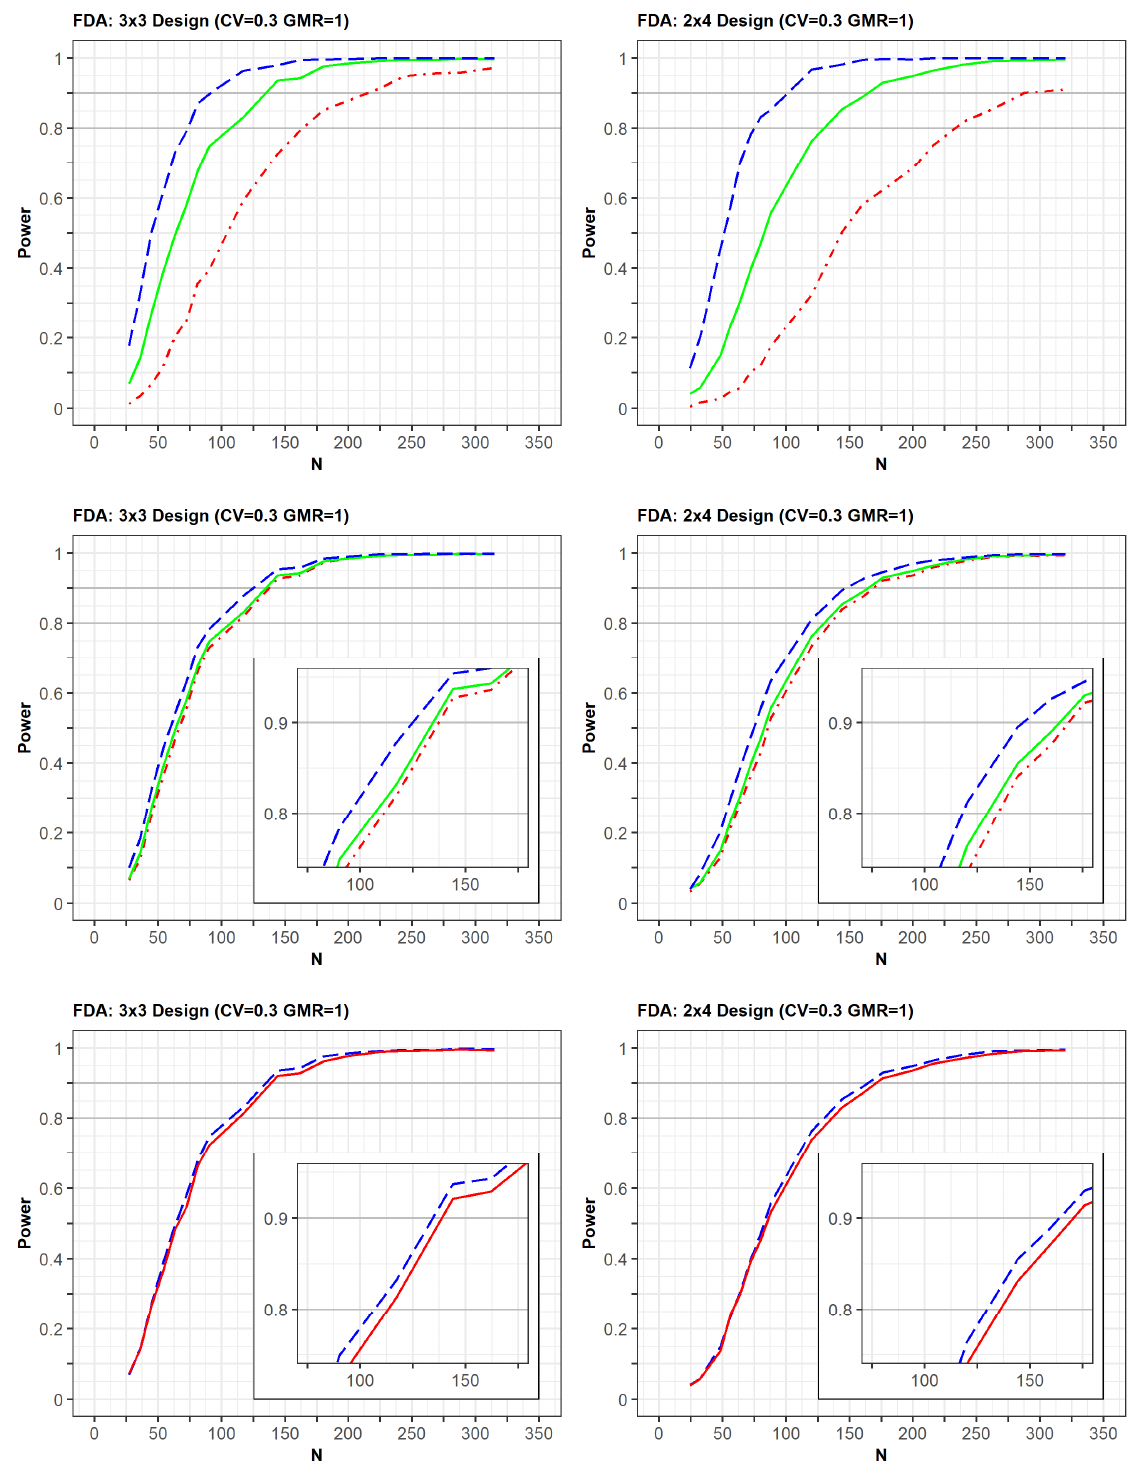
Figure 4. Comparison of power among clinical trial designs by (1) correlation coefficient of bioavailability between reference and test drugs [upper panel: 0.7 (red), 0.9 (green), 1.0 (blue)]; (2) correlation coefficient of absorption rate constant (Ka) between reference and test drugs [middle panel: 0.7 (red), 0.8 (green), 1.0 (blue)], (3) typical value of Ka [below panel: 1.34 (blue), 1.38 (red)]. The x-axis and y-axis represent the total number of trials (N) and statistical power, respectively.